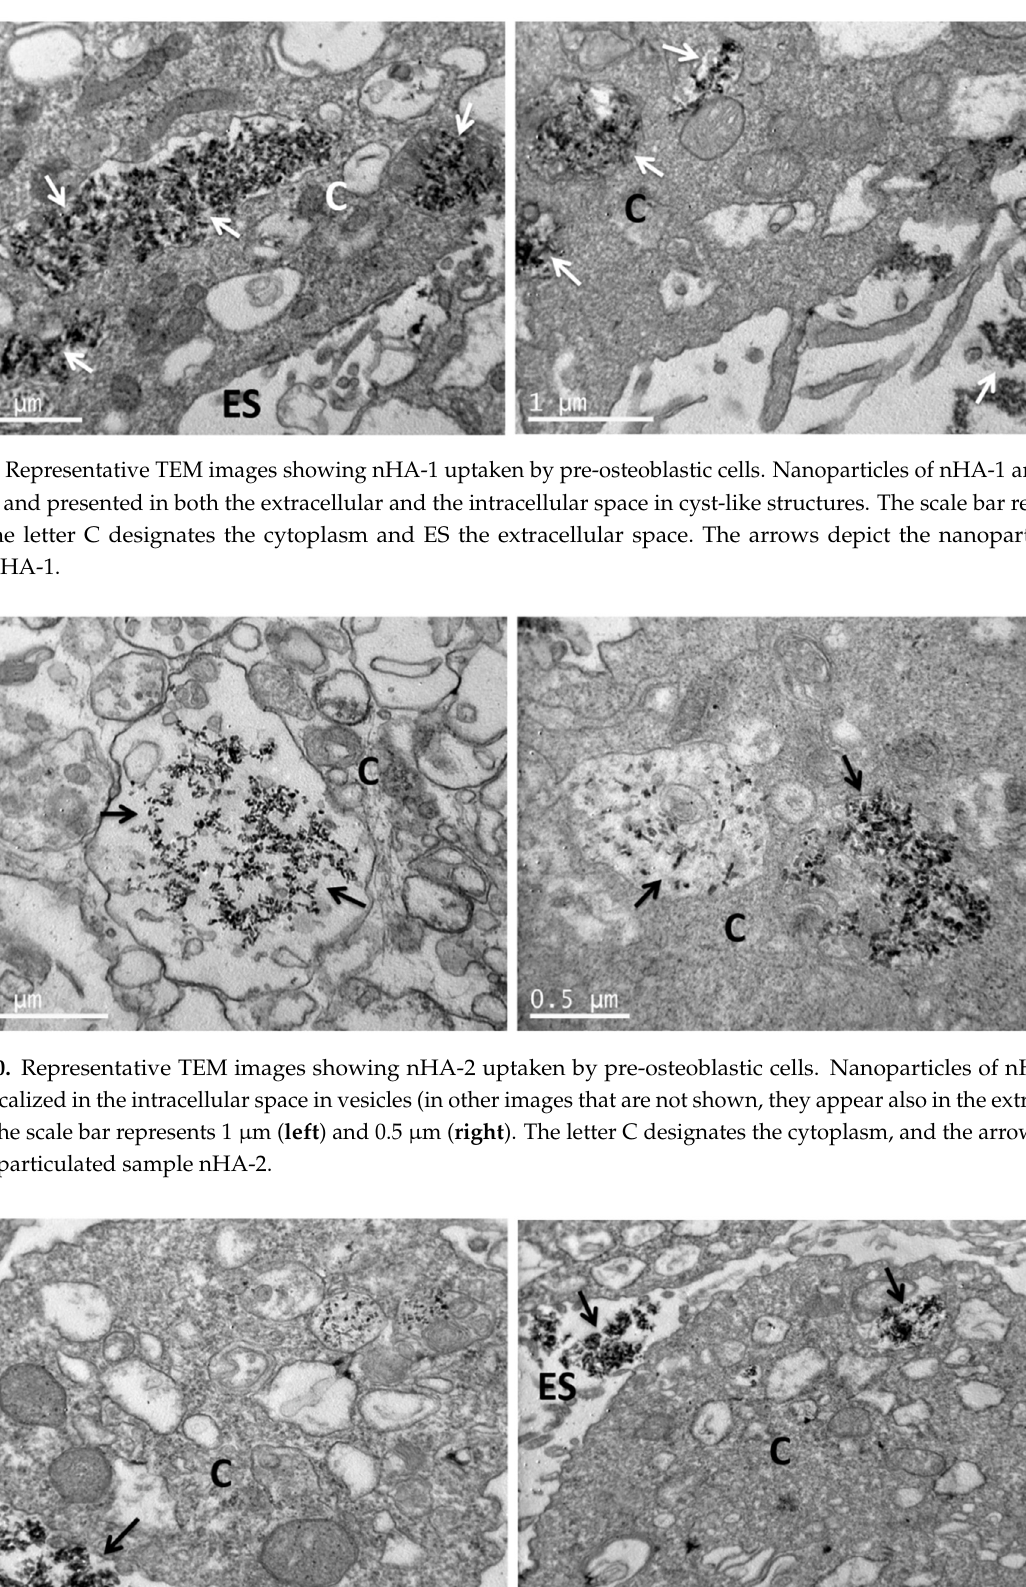
Figure 8. Representative TEM images showing pre-osteoblastic cells (control) in the absence of any nHA samples. The scale bar represents 200 nm (left) and 2 μ m (right). The letter N designates the nucleus, C the cytoplasm and ES the extra- cellular space.